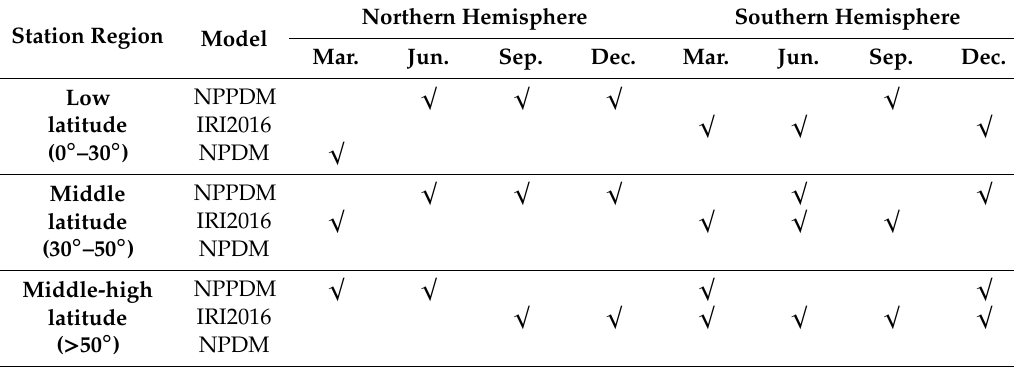
Table 3. Models with the smallest analog deviations in the selected stations under low solar activity. Station